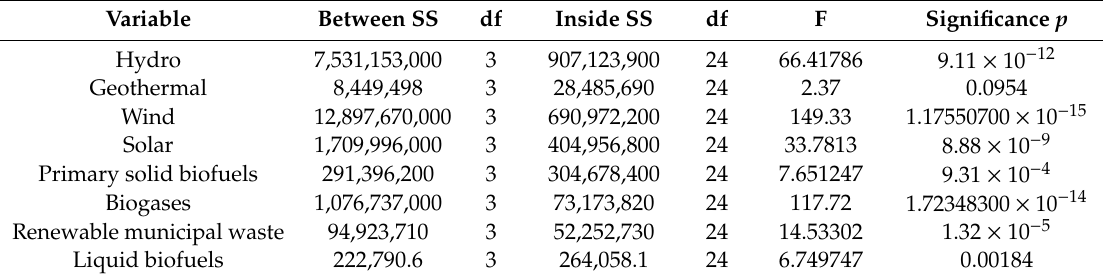
Table 13. Analysis of variance for renewable energy production (own